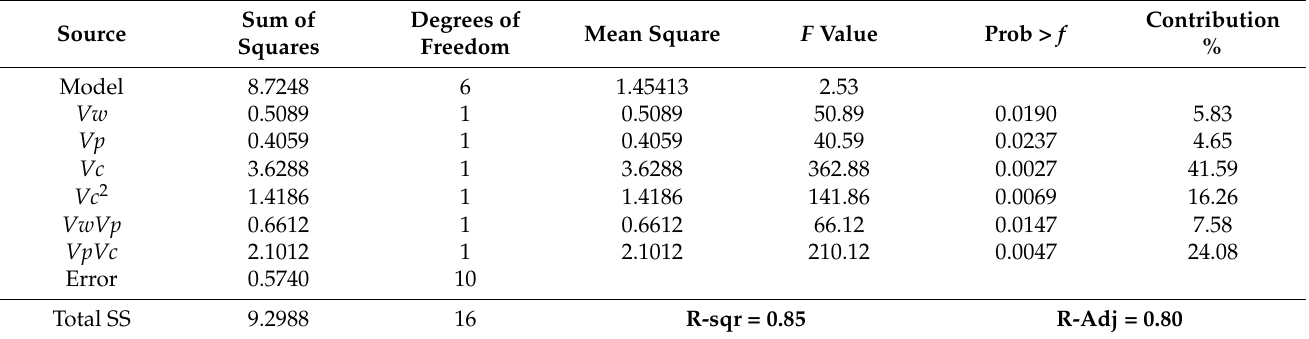
Table 8. ANOVA table for Sa (after elimination) for a conventional wheel.